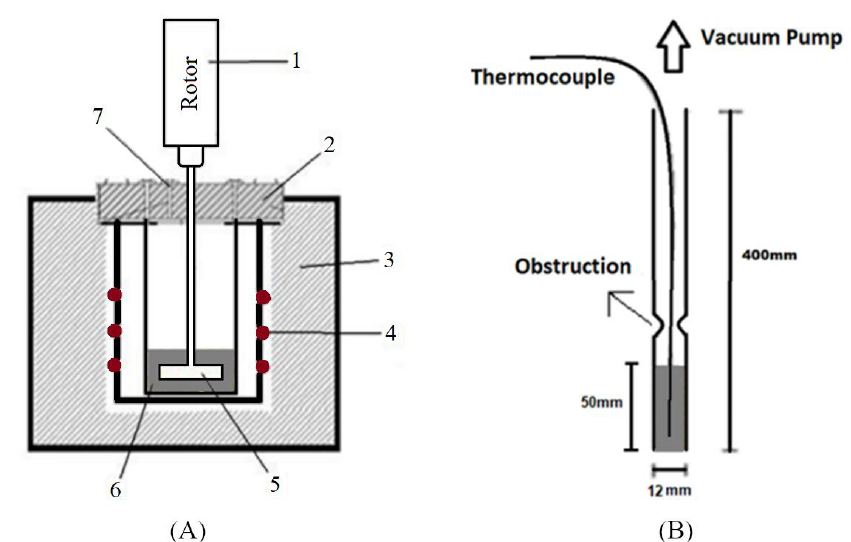
Figure 1. Scheme of the experimental apparatus, with detail of the tube for sample acquisition. (A) Electrical resistance furnace. (1) Rotor; (2) Furnace lid with access to stirring tool, thermocouples and the tubes; (3) Thermal insulation; (4) Electrical resistances; (5) Stirring tool (110 x 25 x 3 mm); (6) Liquid metal; (7) Argon injection access. (B) Scheme of the 12 mm